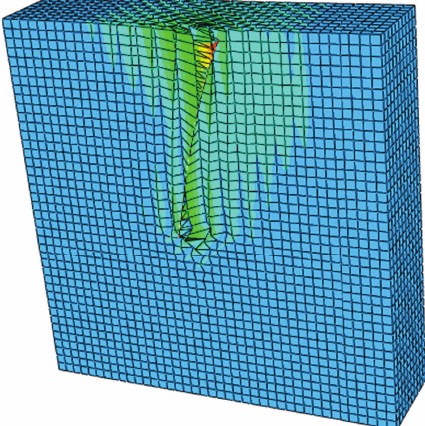
F 3: Deformation of the soil with the 1D model of the